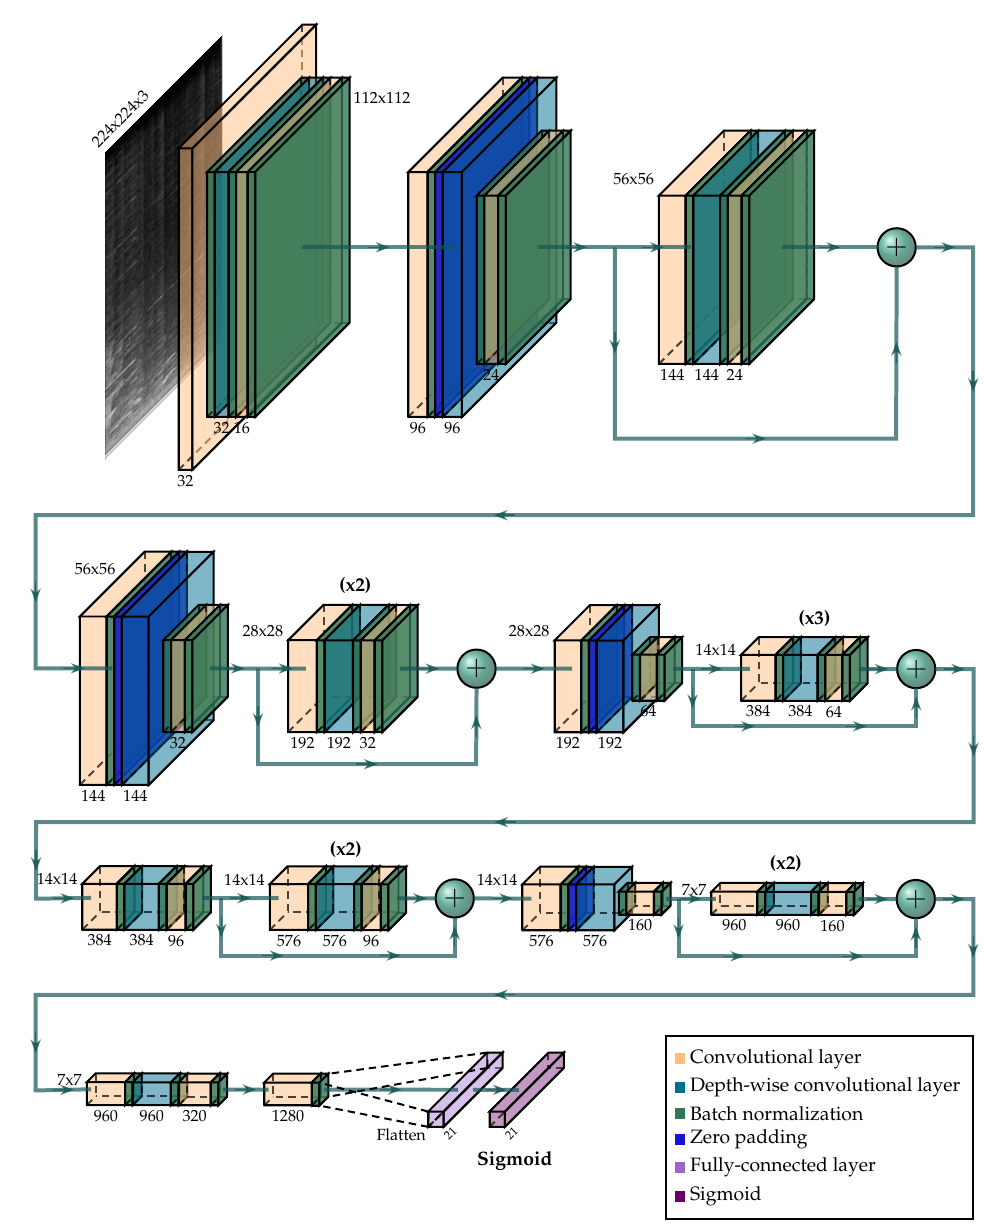
Figure 5. Architecture of the MobileNet v2 [59] deep neural network used at the first stage of the classification